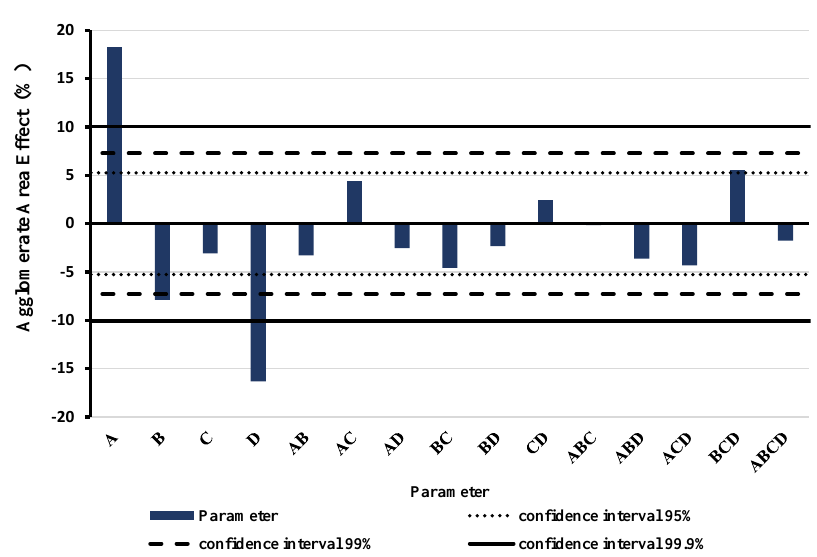
Figure 7. Results of the full factorial design of experiments of rotor-stator (RS) method. Blue bars show the effect of the single parameter (A = MWCNTs weight concentration, B = treatment duration, C = CA weight concentration, D = revolution speed) and the interactions between parameters based on the relative agglomerate area.